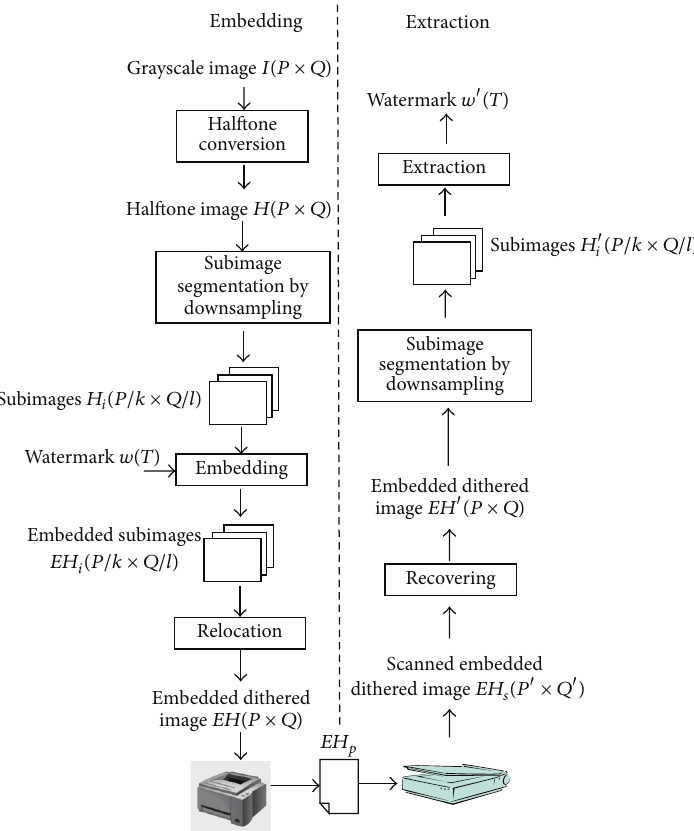
Figure 3: The block diagram of the proposed method.